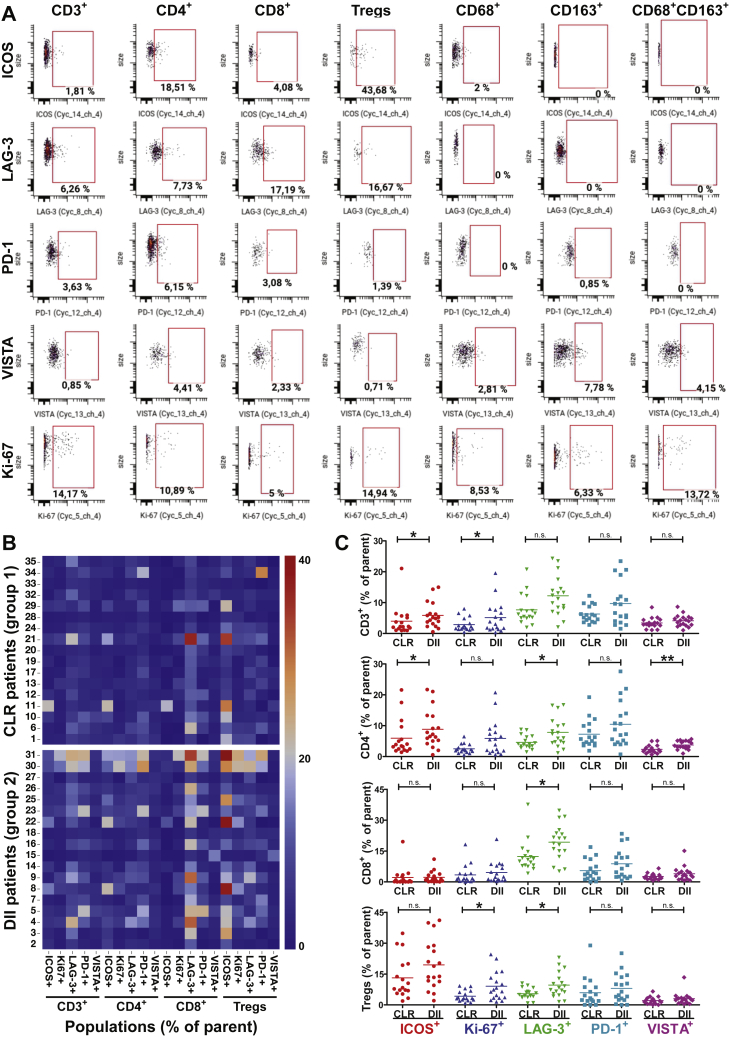
Gating Strategy for Analysis of Checkpoint Molecule Expression on T Cells and Macrophage Populations, Related to Figure 6(A) Representative dot plots from CellEngine are shown for each marker and population. (B) Heatmap of marker-positive cell populations per patient. (C) Frequencies of marker-positive cell populations per patient. Data are mean values from four biological replicates (TMA cores) per patient (∗p < 0.05, ∗∗p < 0.01, Student’s t test).